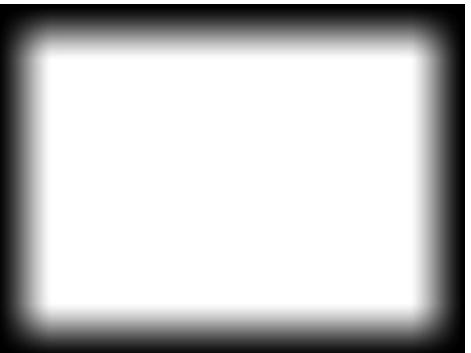
Figure 4. Predefined opacity map for